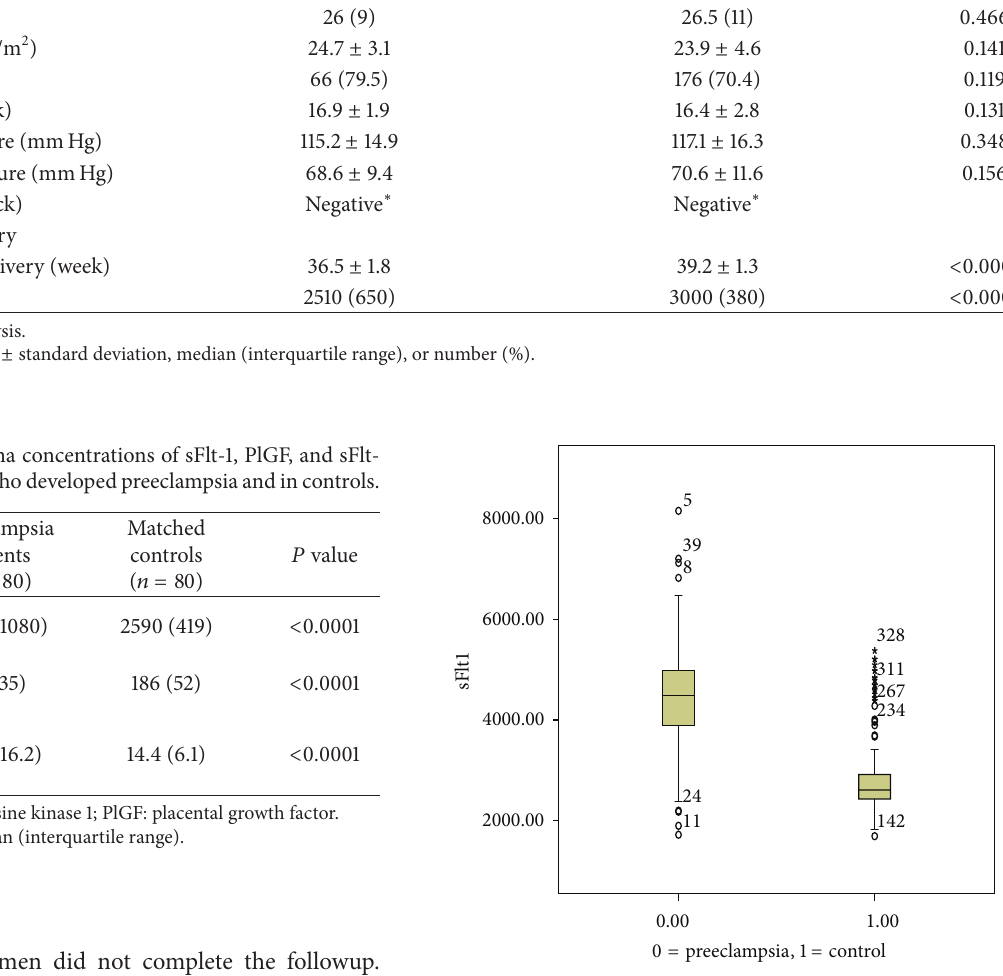
Figure 1: Median and interquartile range of fms-like tyrosine kinase (sFlt-1) in case group, 4490 (961) and in control group, 2591 (400); 𝑃 < 0.0001 .